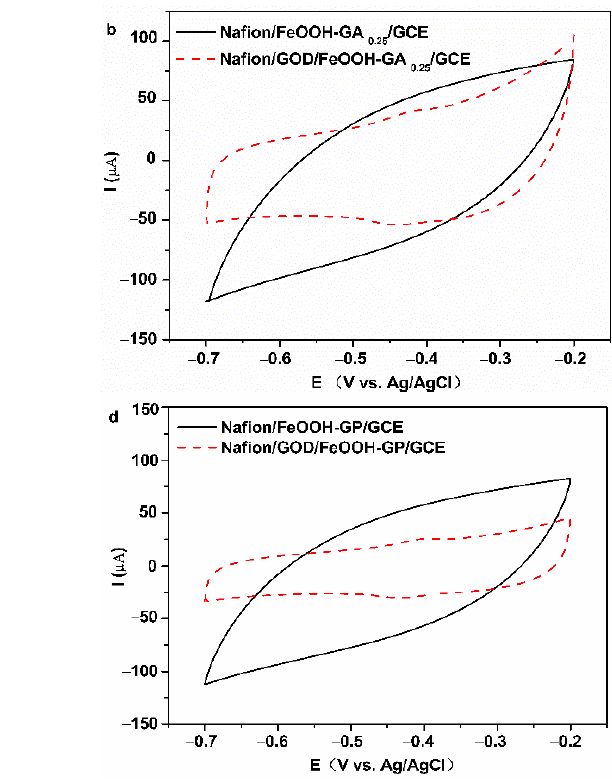
Figure 6. The CV curves of Nafion/FeOOH-GA 0.125 /GCE and Nafion/GOD/FeOOH-GA 0.125 /GCE ( a ), Nafion/FeOOH-GA 0.25 /GCE and Nafion/GOD/FeOOH-GA 0.25 /GCE ( b ), Nafion/FeOOH-GA 1.0 /GCE and Nafion/GOD/FeOOH-GA 1.0 /GCE ( c ), Nafion/FeOOH-GP/GCE and Nafion/GOD/FeOOH- GP/GCE ( d ) at 50 mV s − 1 scan